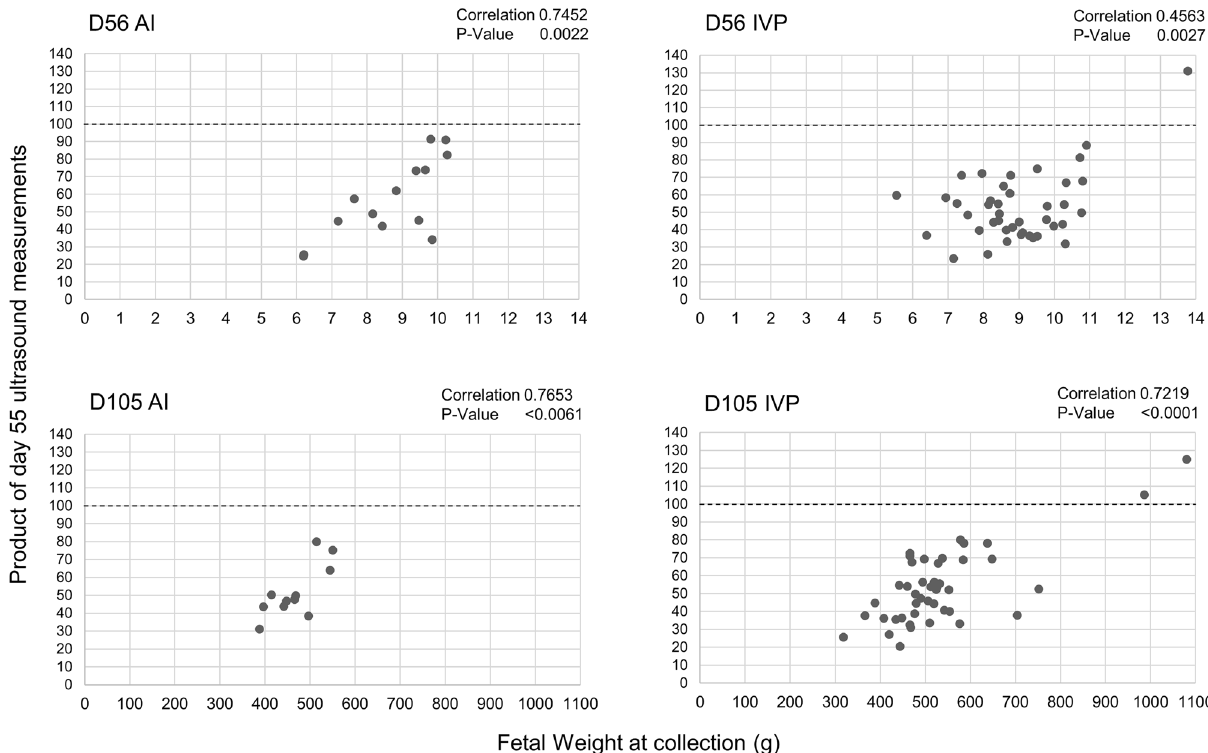
Figure 6. Correlation between fetal weight at collection and the product of D55 ultrasonographic measurements. Ultrasonographic measurements included = abdominal diameter, abdominal height, crown- rump length, head length, thoracic height, and thoracic diameter. AI artificial insemination (i.e., control), IVP in vitro produced embryos. The dashed line on the 100 mark is used to separate the two largest LOS fetuses on day 105 (bottom right panel) and drawn on the other three panels for